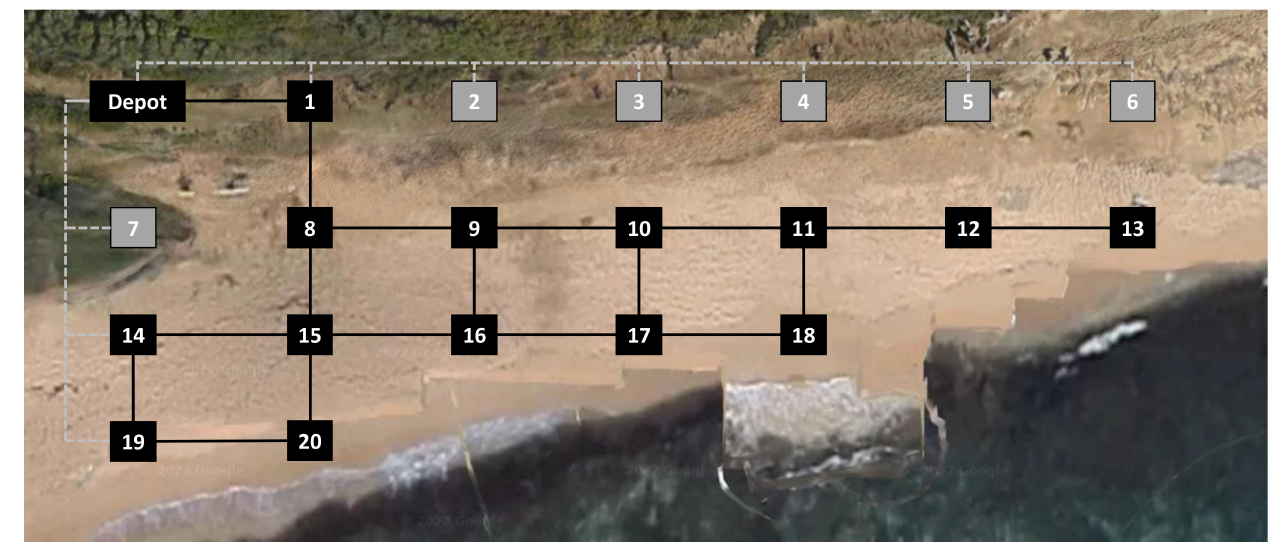
Figure 2. Hypothetical beach area for providing a delivery service by both UGVs and